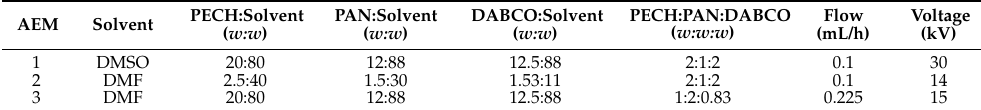
Table 1. Anion exchange membrane (AEM) preparation parameters.